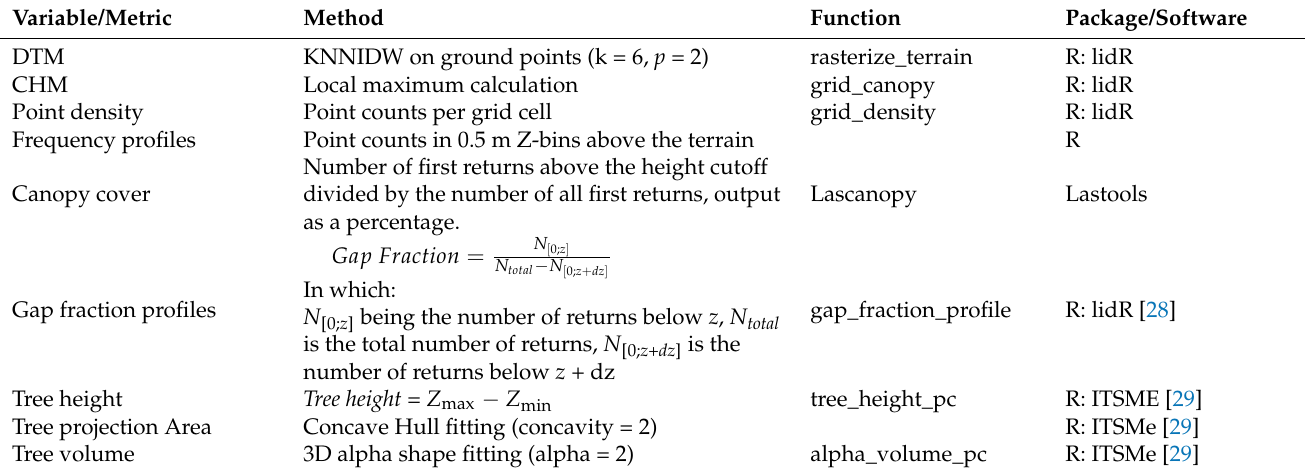
Table 2. Overview of calculated metrics and methods used to calculate